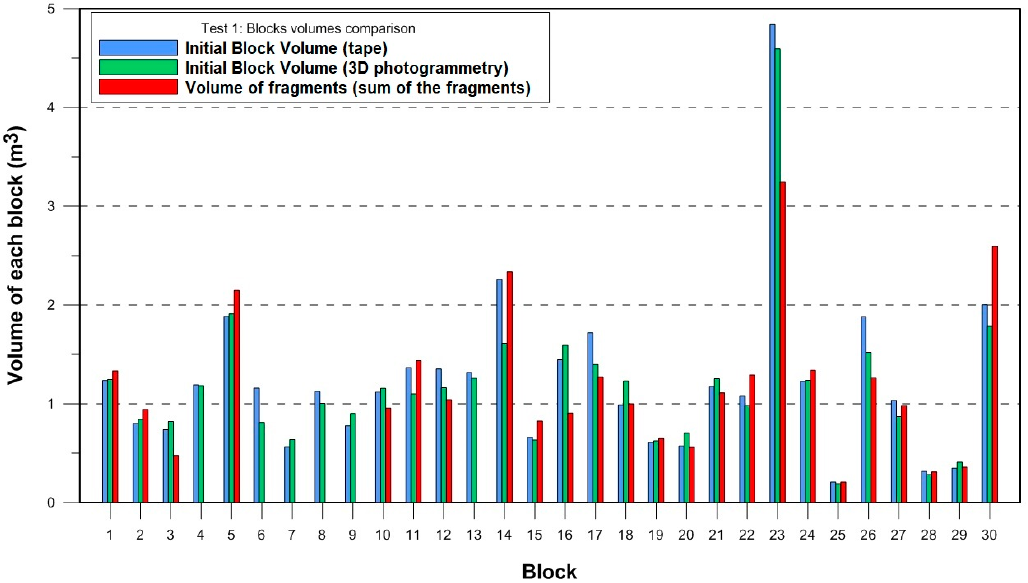
Figure 6. Initial block volume measured with a tape, initial block volume from 3D models and sum of the generated fragments’ volume, in test 1.